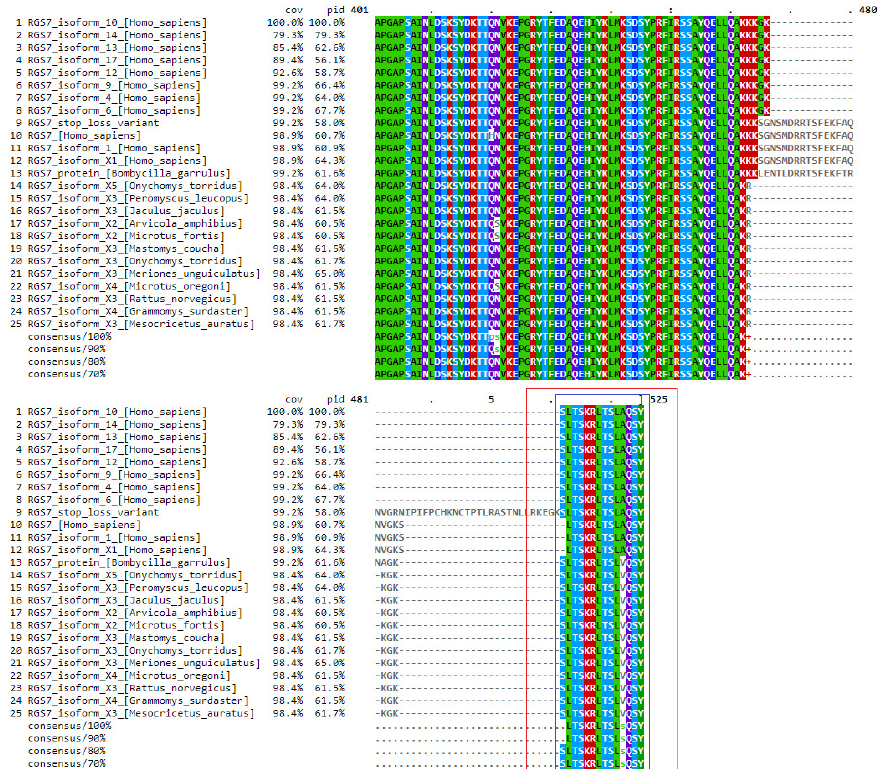
Figure 5. MSA shows that 14 amino acids in the extended protein sequence of RGS7 were conserved in many organisms’ reference sequences. The red box shows the extended protein sequence of RGS7 and the blue box shows the conserved 14 amino acids in the extended protein sequence of RGS7 . The extended protein sequence is started from the 504th position of alignment and ends at the 522nd position of alignment (19 amino acids long), shown in the red box. The first five amino acid residues of extended protein sequence (R (Arginine), K (Lysine), E (Glutamic), G (Glycine), K (Lysine) are not conserved in any sequence but the last 14 amino acid residues are conserved in all of the sequences except for amino acid residue A (Alanine) at position 519 of the alignment which is conserved in Homo Sapiens but it is replaced by V (Valine) in the rest of the sequences. The protein sequence is conserved in vertebrates (Chondrichthyes, Reptiles, Aves, and mammals).